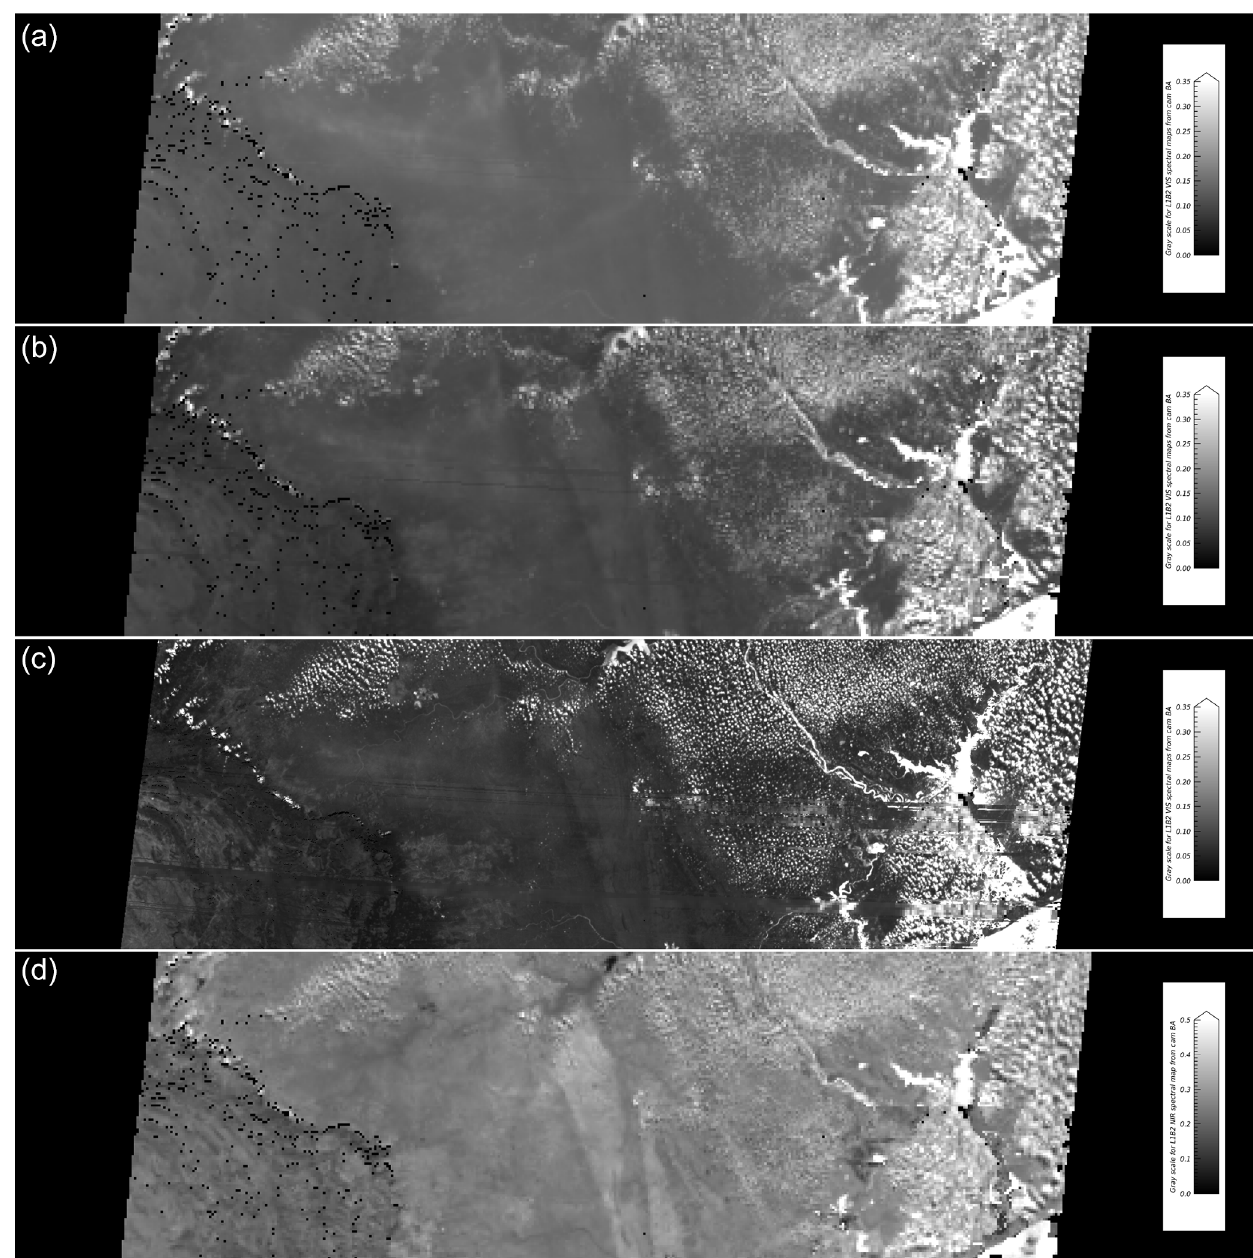
Figure 16. Maps of the updated ToA bidirectional reflectance factor values for GM, P168, O002111, B110 and camera BA in (from top to bottom) the blue, green, red and NIR spectral bands. Achieving this level of replacement required eight iterations (see text for details). The linear dimensions are the same as in Fig. 1, and gray scale stretching is the same as before: it assigns black to a null reflectance and white to reflectances of 0.35 or more in the blue, green and red spectral bands and 0.50 in the near-infrared spectral band.